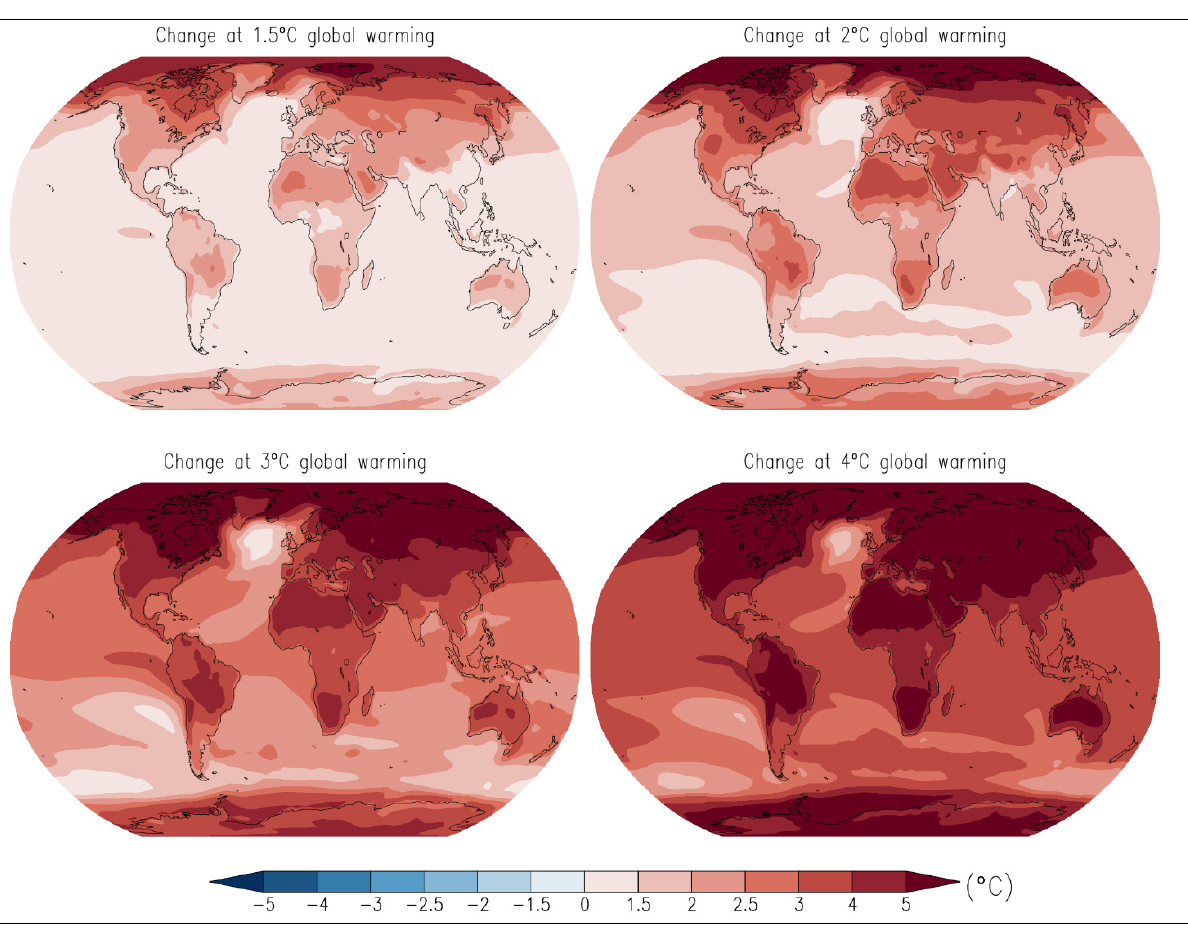
Figure 2: Projected spatial patterns of change in surface temperature (°C) at different levels of global warming (1.5 °C, 2 °C, 3 °C, and 4 °C) relative to the period 1850–1900. Values were assessed from a 20-year period at a given warming level, based on model simulations under SSP5-8.5 by 30 global circulation models that contributed to the Coupled Model Intercomparison Project Phase Six